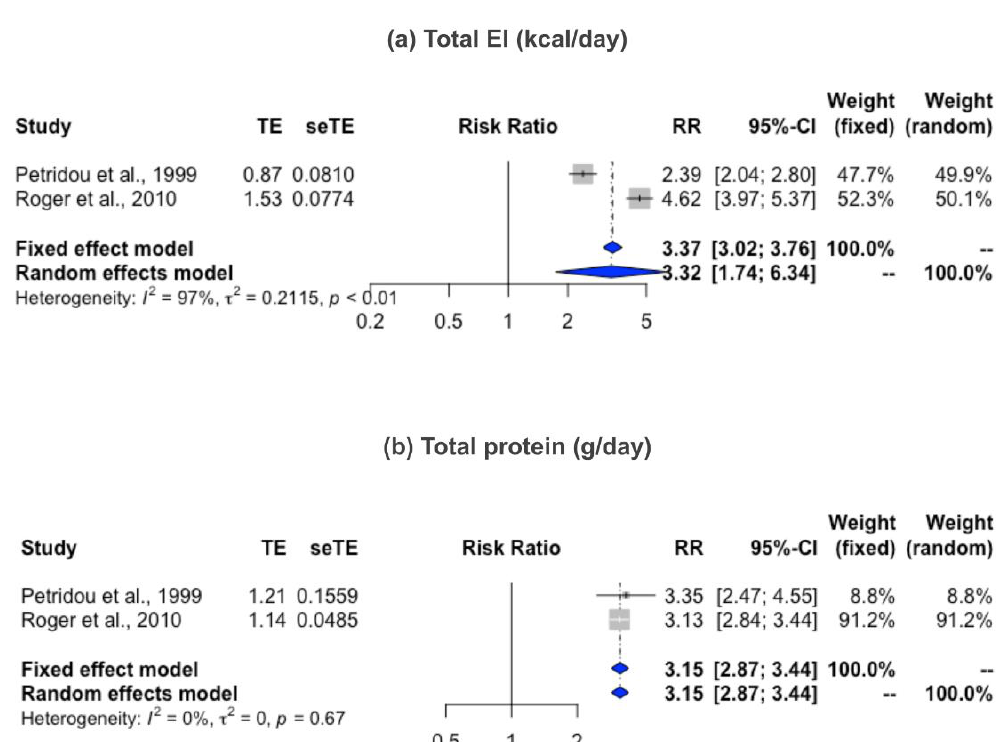
Figure 2. Forest plot of WMD of EI between EMO and NEMO groups stratified by BMI < 18.5 kg/m 2 and BMI  18.5 kg/m 2 . Definition of abbreviations: EMO, earlier menarche onset; NEMO, non-early menarche onset; MD, mean difference; WMD, weighted mean difference.